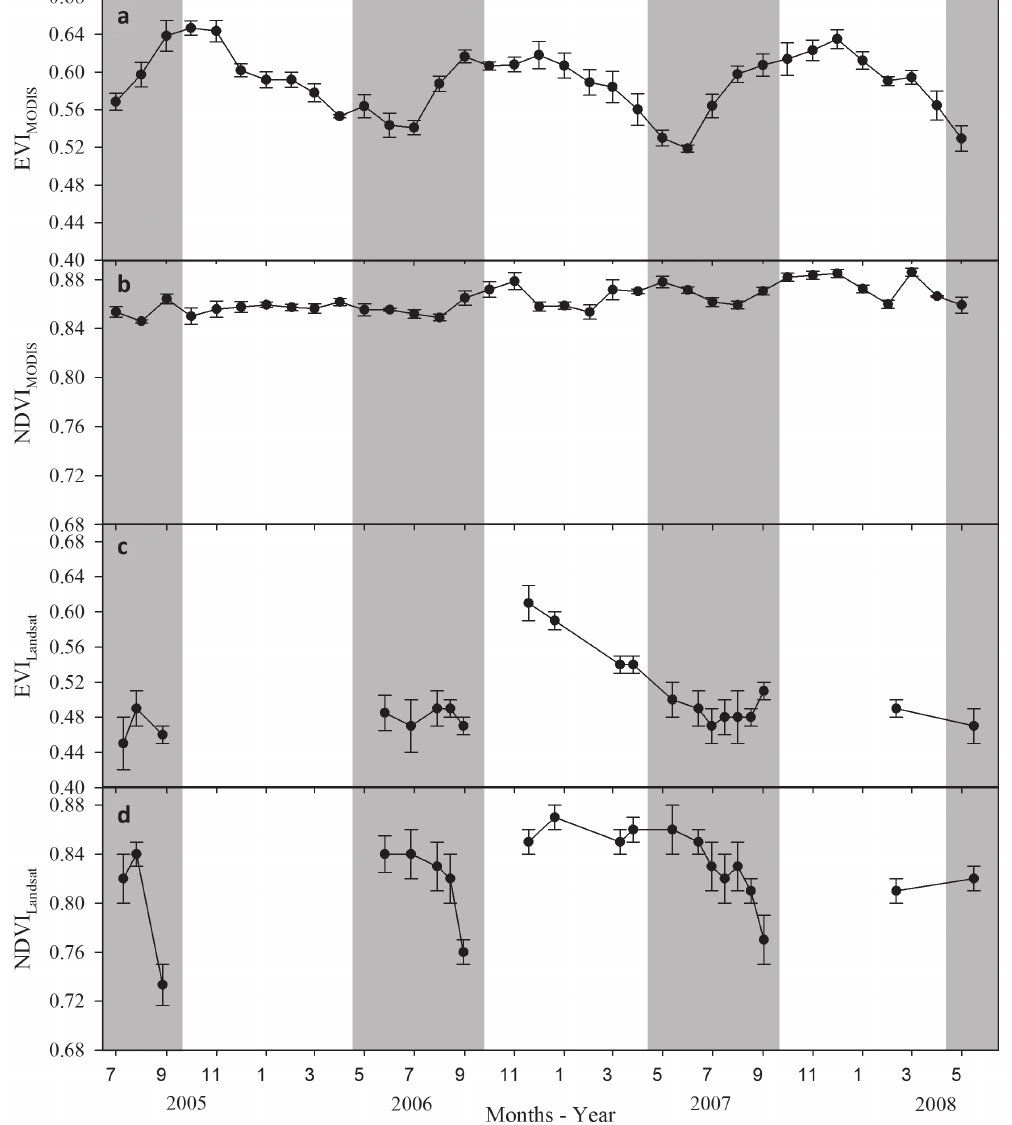
Fig. 3 - Monthly average of the Enhanced Vegetation Index (EVI) calculated form Moderate Resolution Imaging Spectroradiometer (MODIS) ( a ) and Landsat 5 TM ( c ) and Normalized Difference Vegetation Index (NDVI) calculated from MODIS ( b ) and Landsat 5 TM ( d ) in the Amazon-Cerrado transitional forest from July 2005 to June 2008. The gray vertical column represents the dry